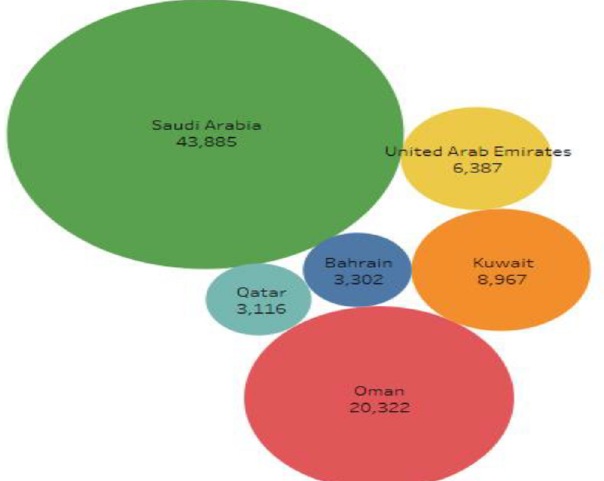
Figure 3. Active cases